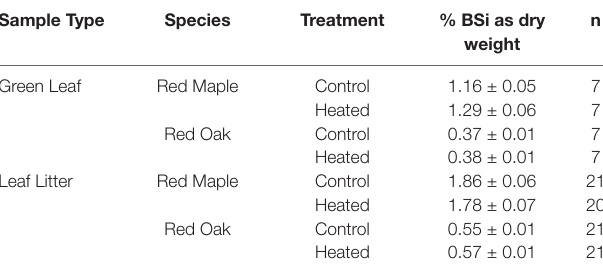
TABLE 3 | Foliar and litter BSi concentrations. The values reported are mean concentrations of BSi (percent dry weight) across all samples analyzed (all sampled during experimental treatment, from 7 years between 2003 and 2016; further detailed in methods